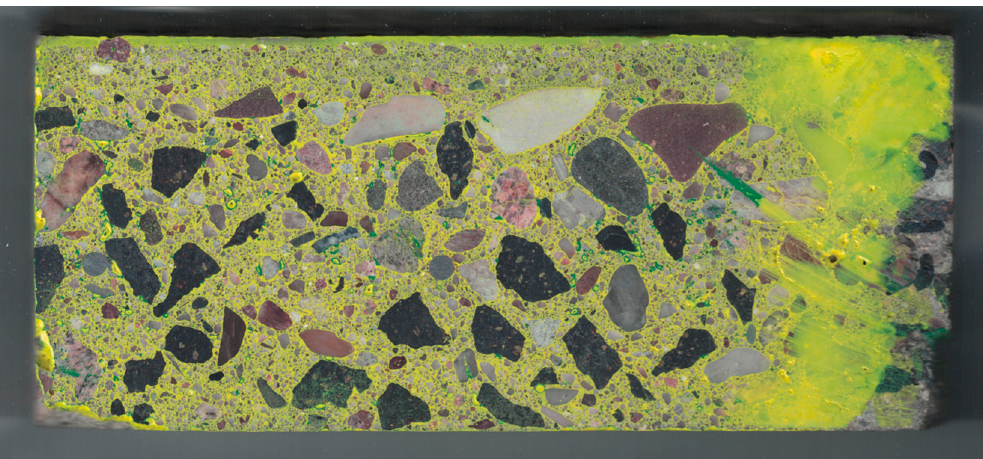
Figure 8. Scan of the tested sample after staining the matrix.